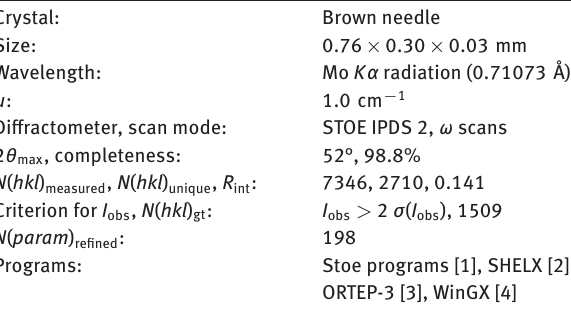
Table 1: Data collection and handling.